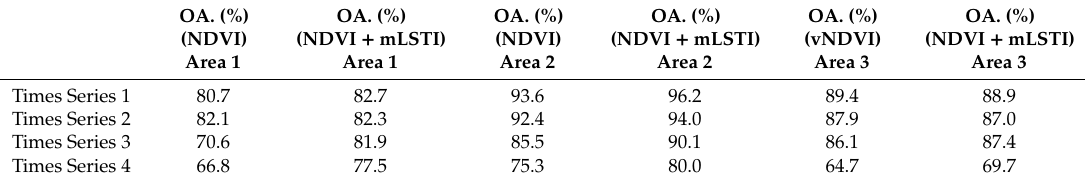
Table 5. Classification accuracy using different short time series.